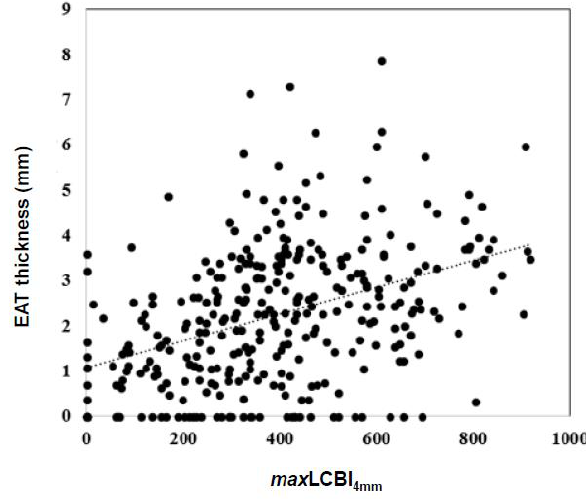
Figure 3. The relationship between EAT and max LCBI 4mm . There was a positive correlation between max LCBI 4mm and EAT ( r = 0.420, r 2 = 0.176, and p < 0.001). p value and coefficients are obtained from simple linear regression analysis. EAT, epicardial adipose tissue; max LCBI 4mm , maximum lipid core burden index in any 4 mm segment.